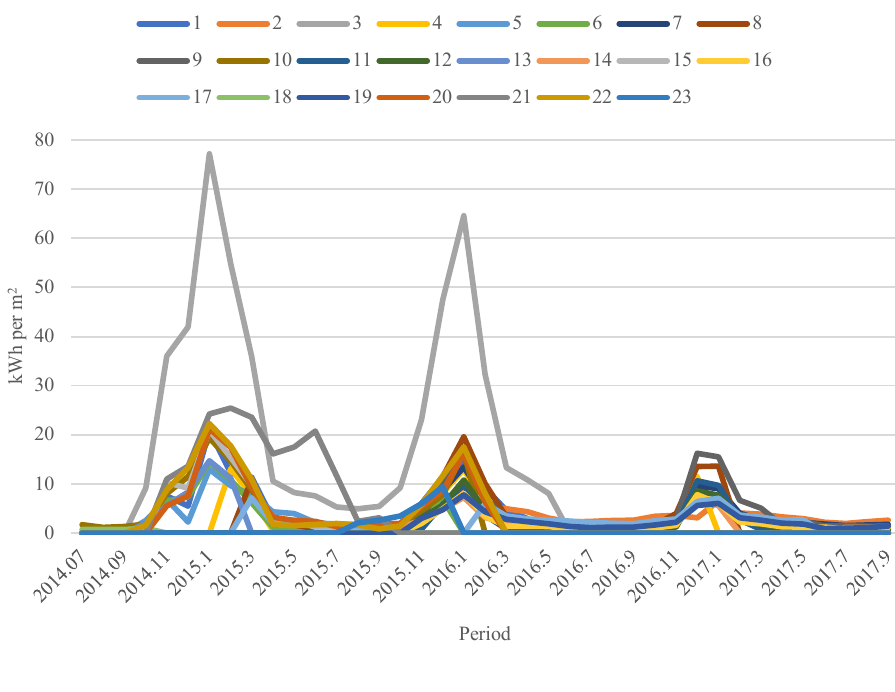
Fig. 4. Energy consumption in kWh per meter square for all